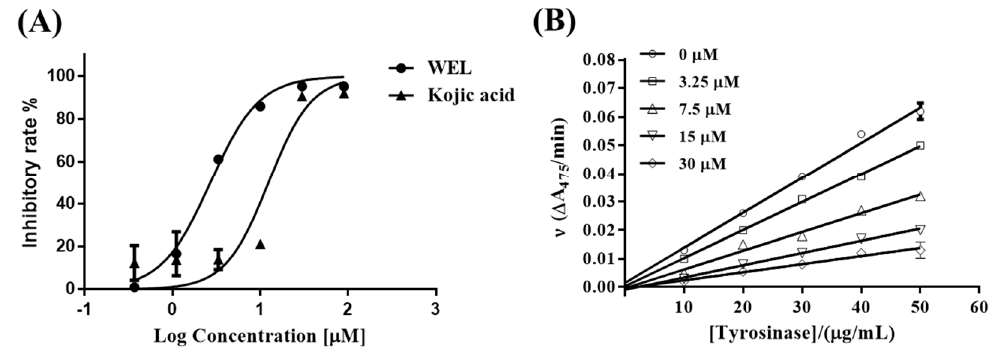
Figure 2. ( A ) Inhibitory activity of WEL and the control Kojic acid on tyrosinase. ( B ) Inhibitory mechanism of WEL on tyrosinase.